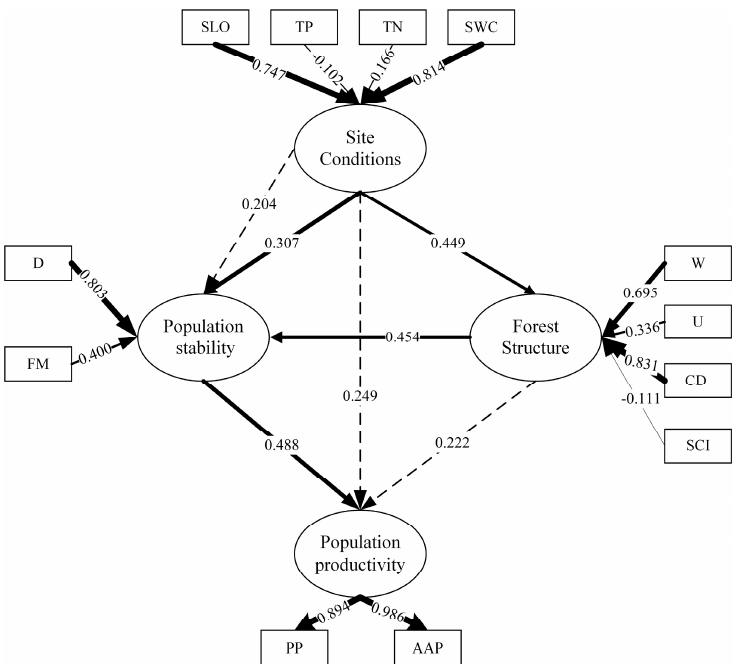
Figure 2. Latent variable path based on CCA results.